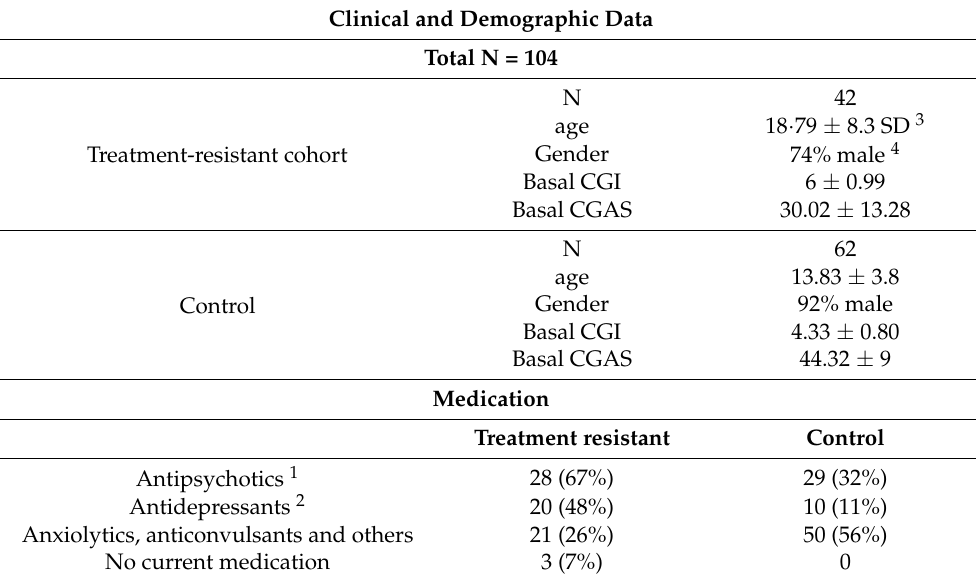
Table 1 summarises the demographic and clinical data of the study participants. Table 1. Clinical and demographic data of investigated